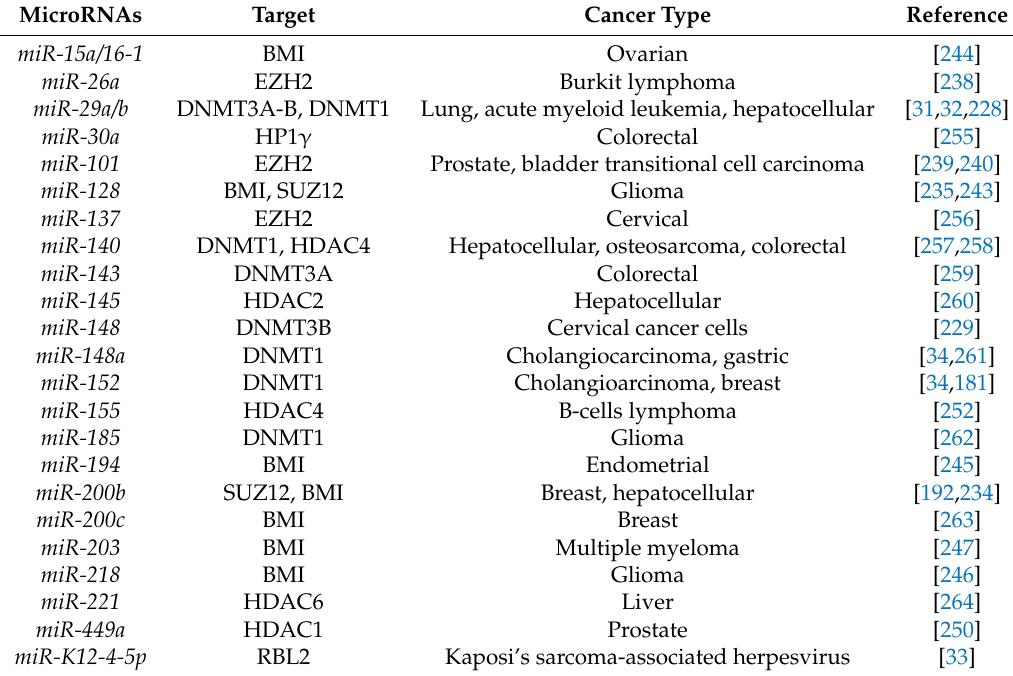
Table 2. MicroRNAs target epigenetic complex at post-transcriptional